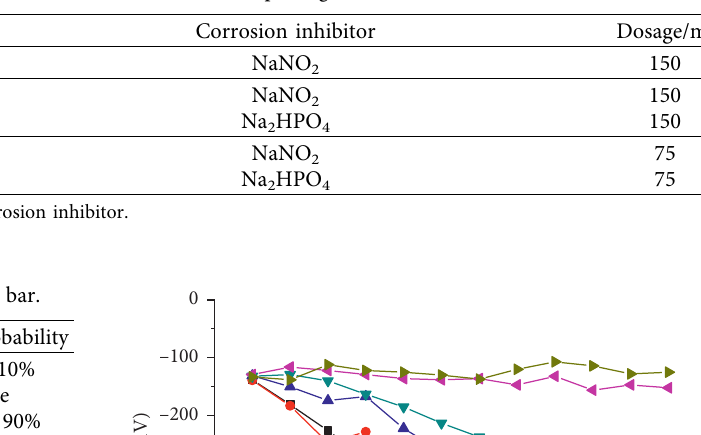
Table 3: Proportion of corrosion inhibitor in repairing test.